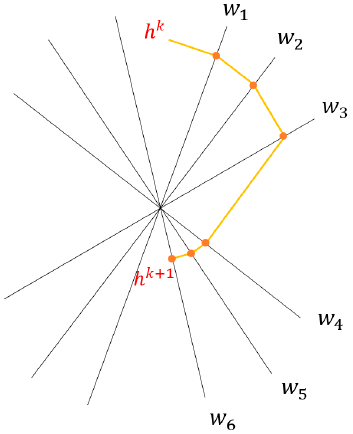
Figure 4. One iteration with the relaxation parameter 𝜆 (cid:3038) = 1 .